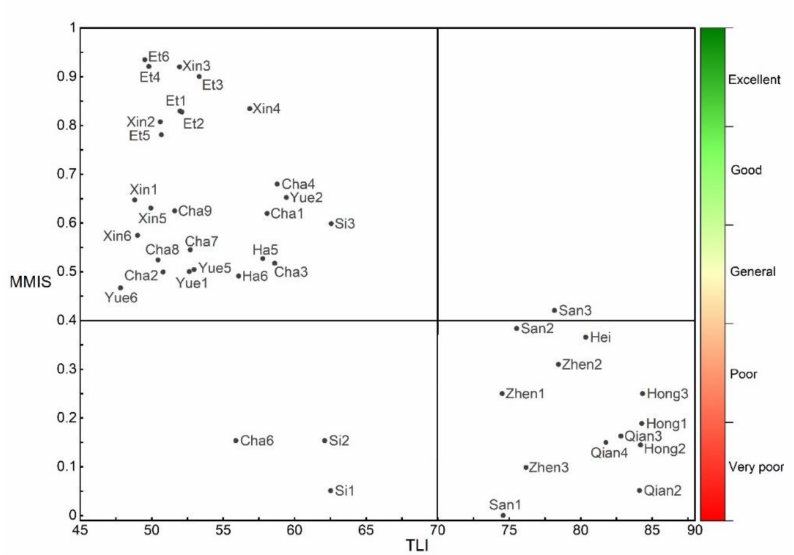
Figure 2. Quadrant diagram of the trophic level index (TLI) and multi-metric index (MMI) of the research site: the horizontal axis represents the TLI value, and the vertical axis represents the MMI value of site (MMIS). The name of black points shown is the abbreviation of the lake + site number. The abbreviation of the lakes’ name is shown in Appendix